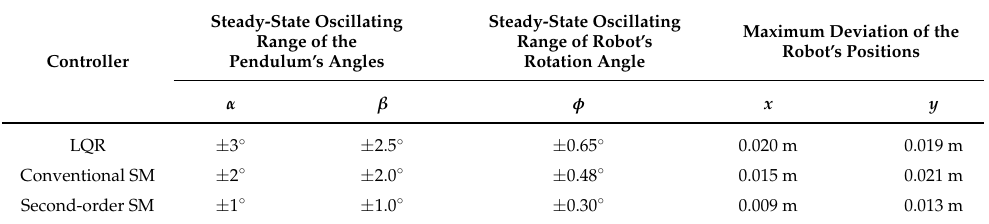
Table 4. The experimental results of the steady-state oscillating range of the pendulum’s angles, the steady-state oscillating range of robot’s rotation angle, and the maximum deviation of the robot’s